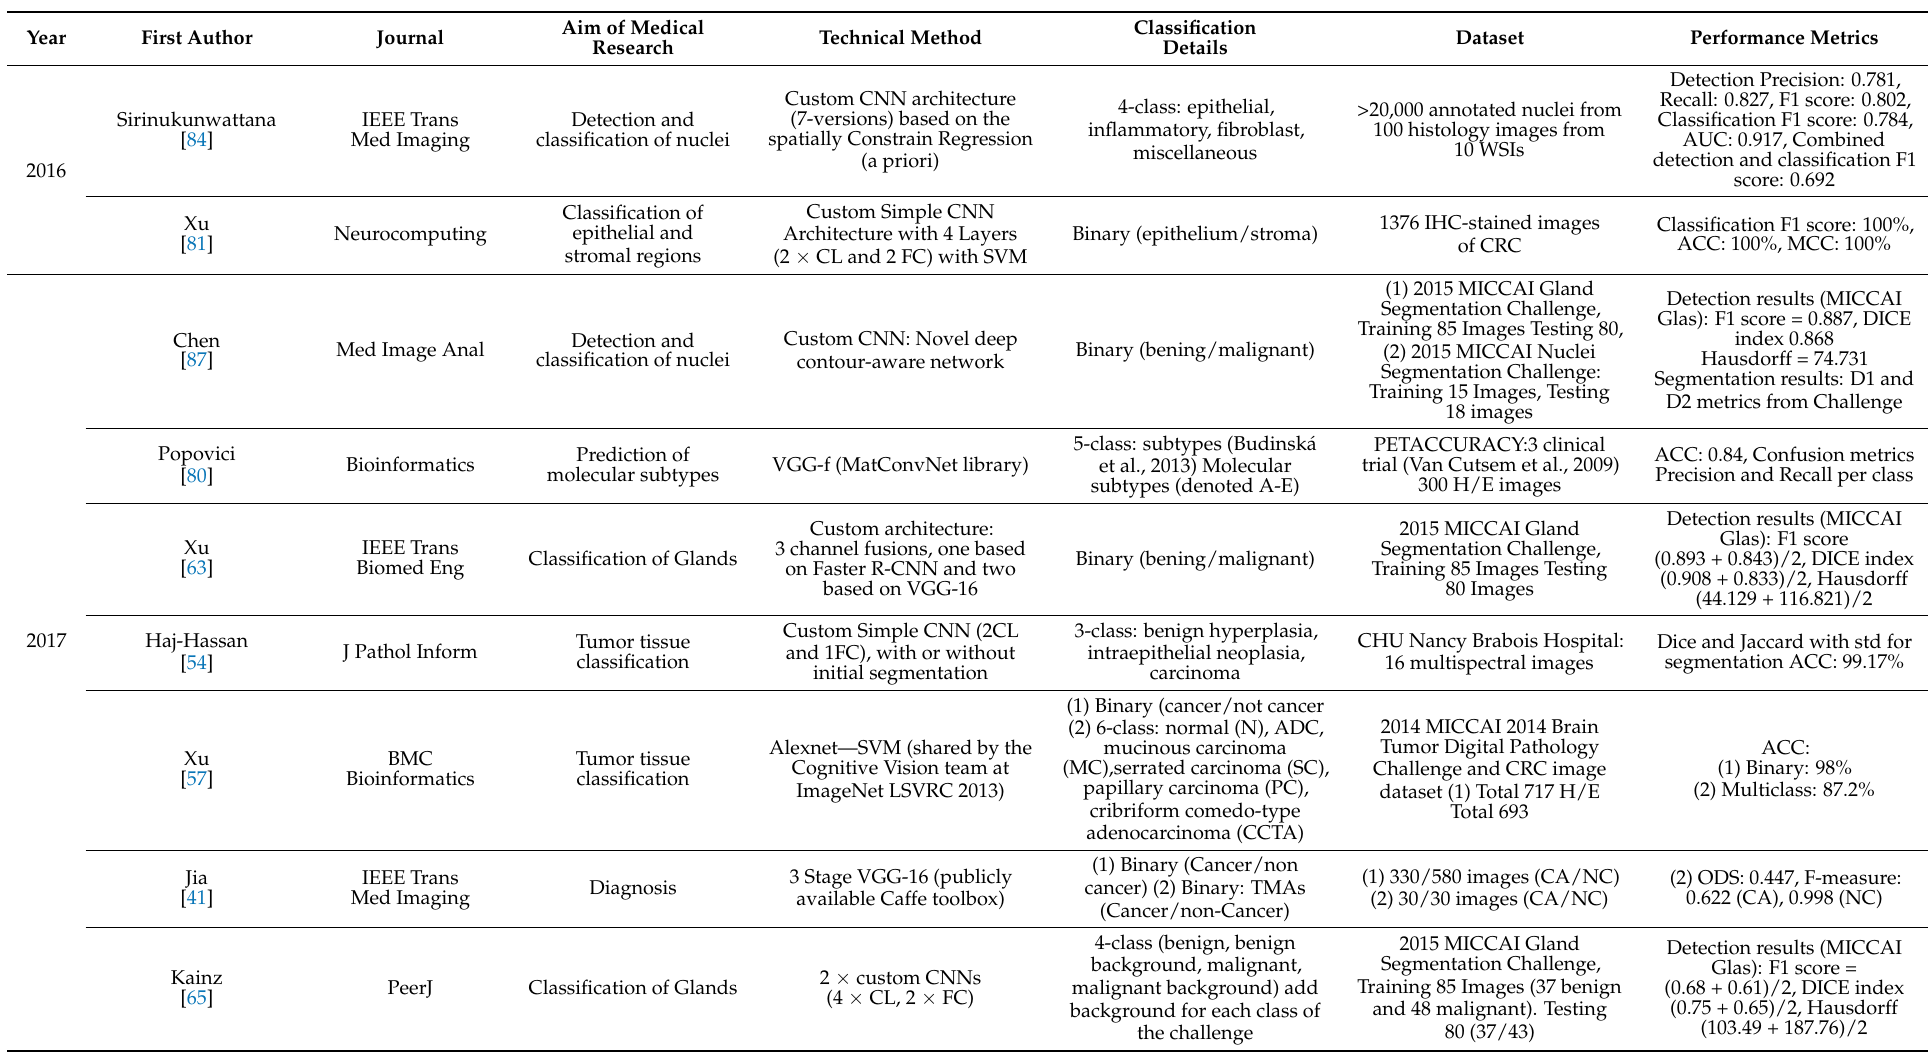
Table 1. Deep learning methods on histopathological images for colorectal cancer